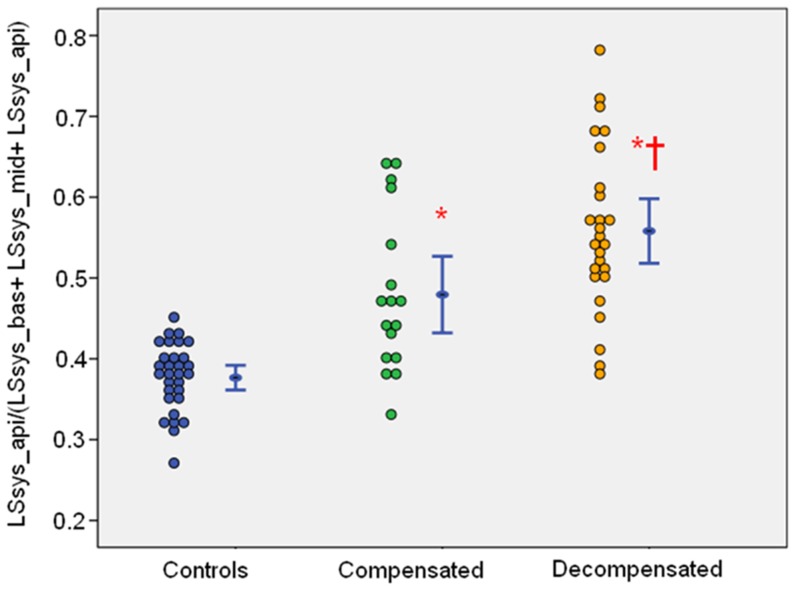
Scatterplot and error bar (mean±2SD) of LSsys_api/(LSsys_bas+LSsys_mid+LSsys_api) in the septum.Pathological base-to-apex gradient was defined as LSsys_api/(LSsys_bas+LSsys_mid+LSsys_api) ≥0.45. Pathological gradient of the septum was present in 32 out of 44 patients (73%) with AL amyloidosis and LV hypertrophy [9 (50%) compensated, 23 (88%) decompensated, P<0.05].*: P<0.05 vs. Controls; †: P<0.05 vs. Compensated group. LSsys_api: apical longitudinal systolic strain; LSsys_mid: mid longitudinal systolic strain; LSsys_bas: basal longitudinal systolic strain.